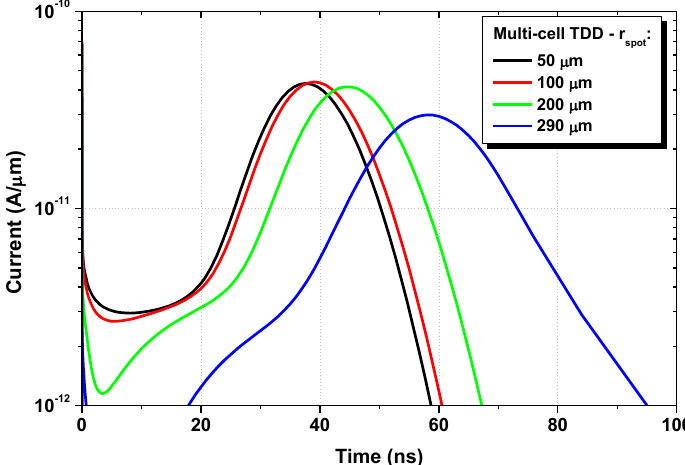
Figure 13. The transient response of the anode current in a single cell of a multi-cell TDD. The width of the impinging light spot was 0.1 µm, the energy 150 eV, and intensity 2 × 10 6 W/cm 2 .